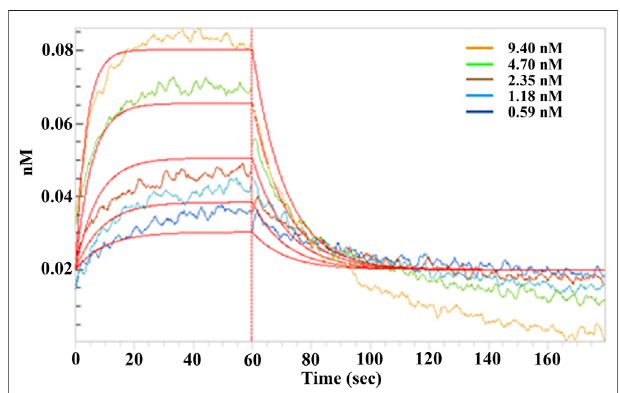
FIGURE1| Bindingaf fi nityassaybetweenSARS-CoV-2RBDandEPSs from H . hispanica . Serially diluted EPSs solutions were incubated with RBD (50 μ g), which was coated on a Ni-NTA sensor for 2 min, and the af fi nity kinetics were analyzed after being dissociated for another 2 min. The binding kinetics between EPSs and RBD were determined by using the biolayer interferometry (BLI) method.